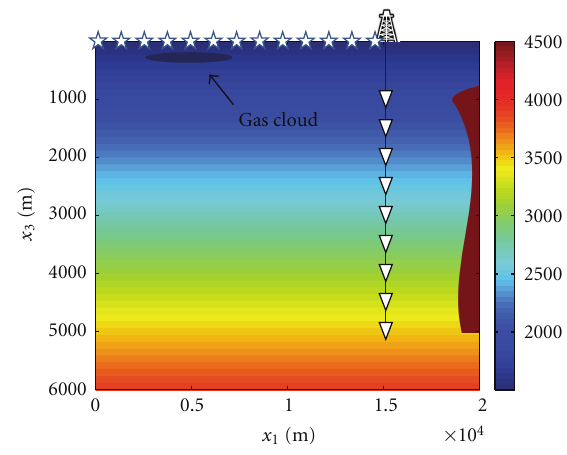
Figure 25: PSF correlation gather for receivers at x A = = (15000m,2000m). (15000m,4000m) and x (cid:7) A